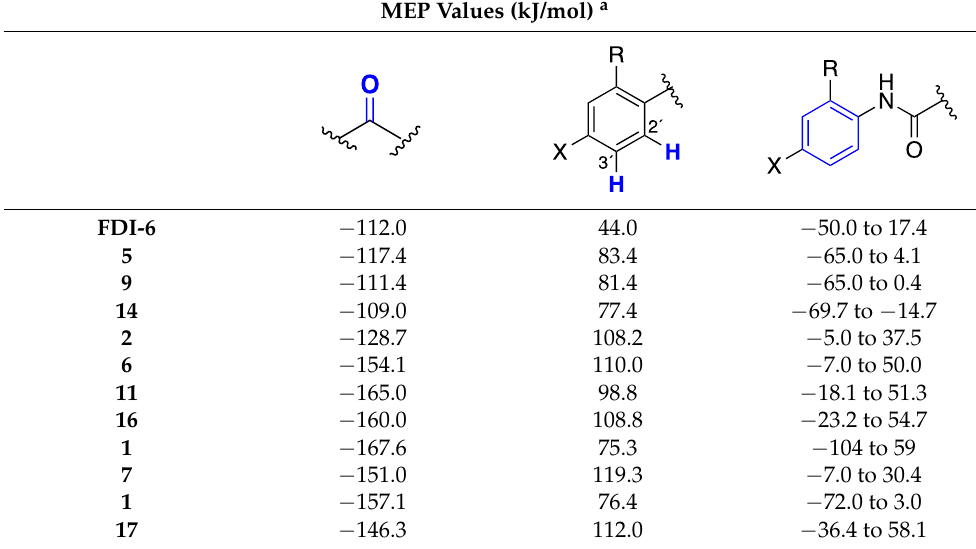
Table 3. Summary of MEP values of selected thieno[2,3- b ]pyridines.